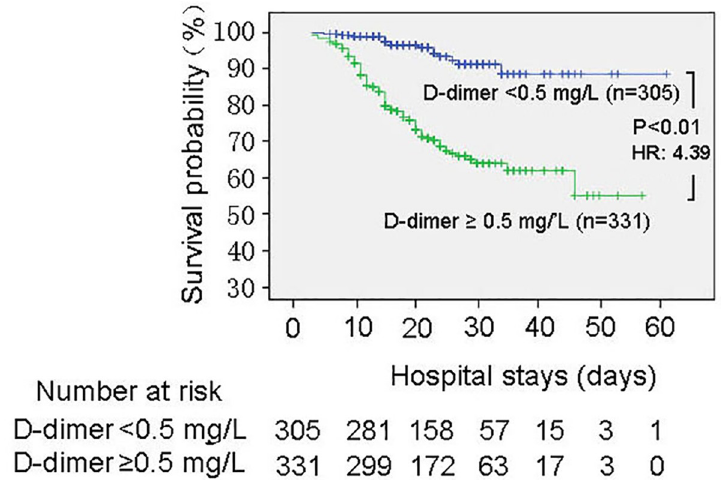
Fig 2. Kaplan-Meier survival curves for D-dimer levels on the initial admission. Statistic significance of separation between two groups was achieved at 8 days after admission. HR: Hazard ratio.